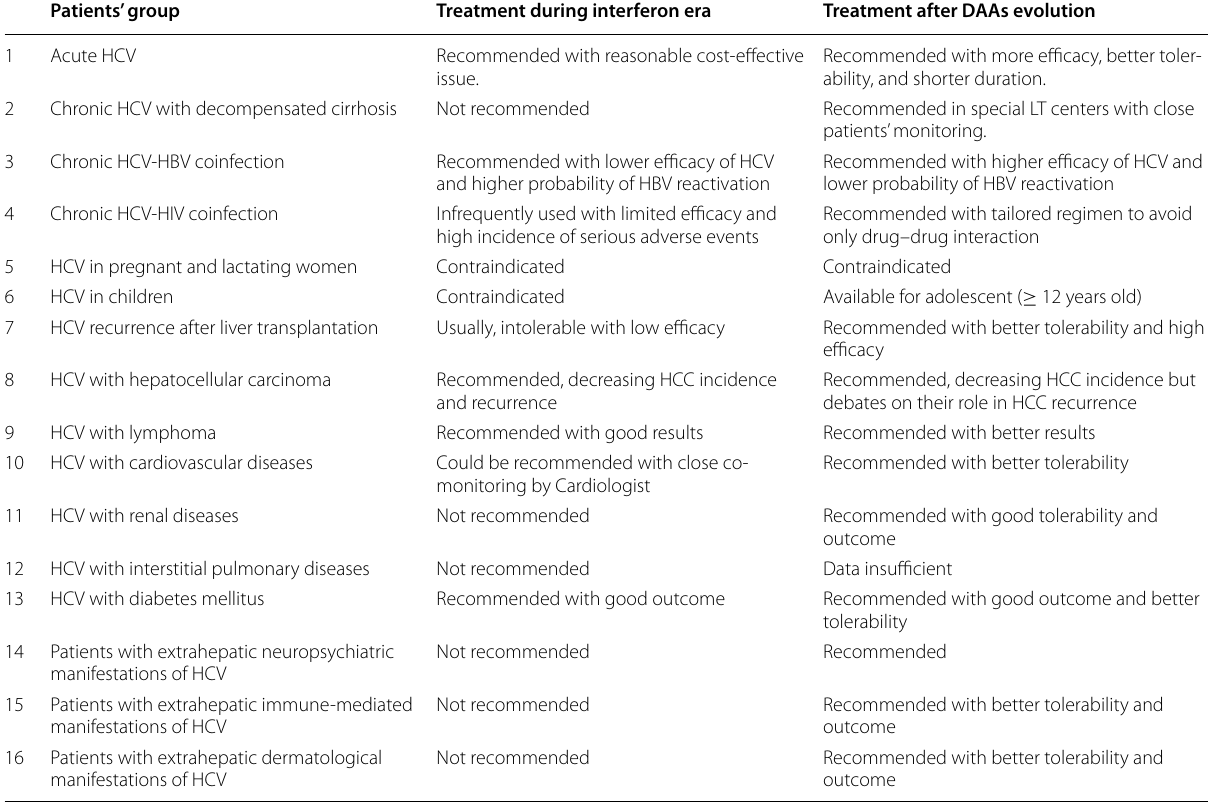
Table 1 Summary of the treatment difference of some special groups of patients during the interferon era and after DAAs